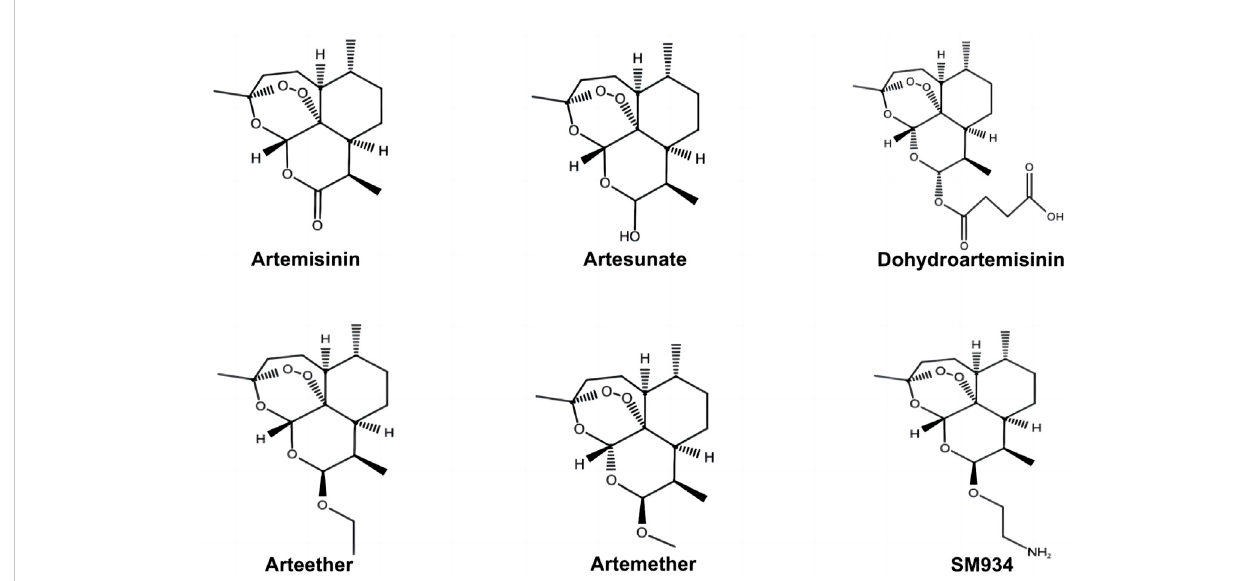
FIGURE 2 Chemical structures of artemisinin and its derivatives. SM934, ß -aminoarteether